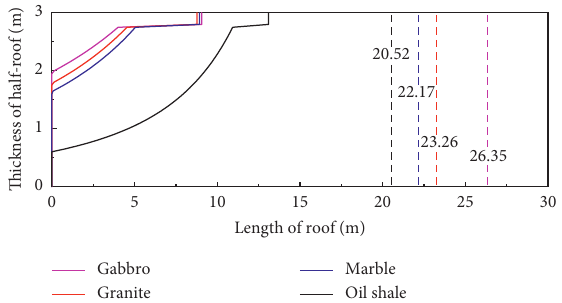
Figure 8: Effect of different roof lithology on the boundary of crack-affected area.